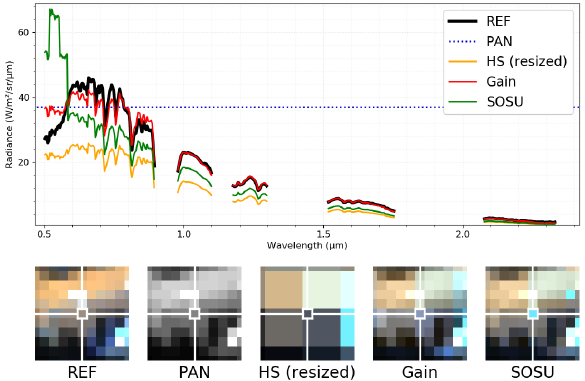
Figure 6. Subpixel degraded by SOSU preprocessing